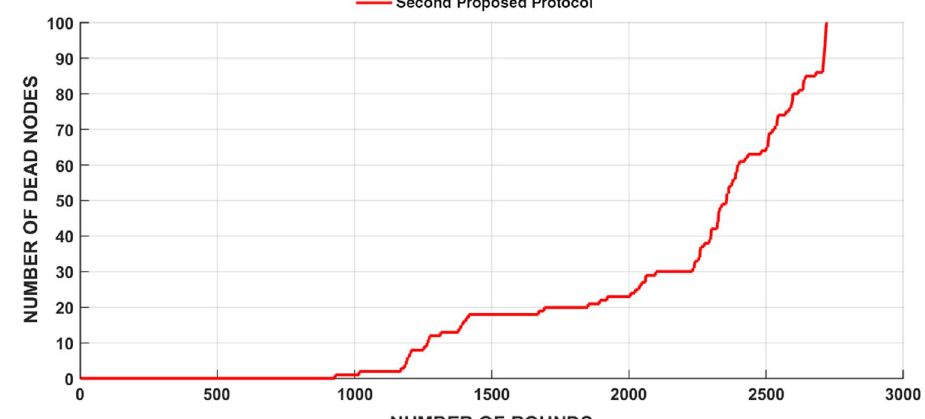
Fig. 14 Ratio of the number of dead nodes to the number of rounds in scenario 3, the second protocol